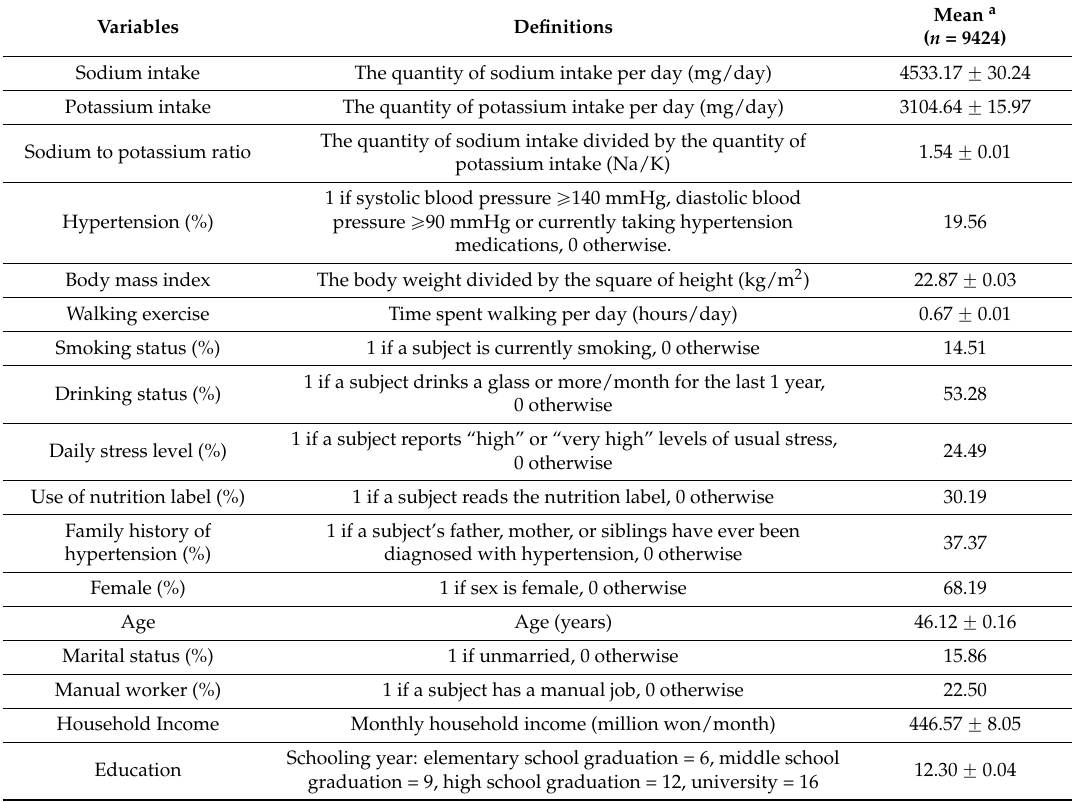
Table 1. Definitions and descriptive statistics of study